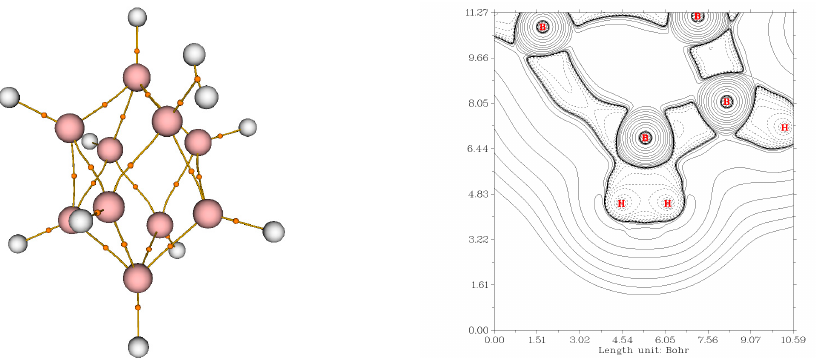
Figure 4. Molecular graph showing the results of the topological analysis of the electron density distribution in the model structure of the [B 10 H 9 (H 2 )] − ; Contour line map of the Laplacian of electron density for B–(H 2 ) fragment, ω B97X-D3/def2-TZVPP level of theory. [B 10 H 9 (H 2 )] − underwent the H 2 elimination process, which is endergonic; Gibbs en-